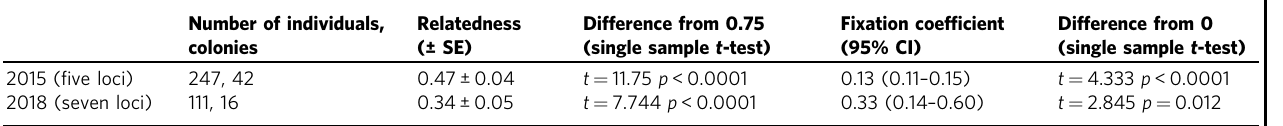
Table 3 Genetic composition of colonies of the ant Cardiocondyla elegans